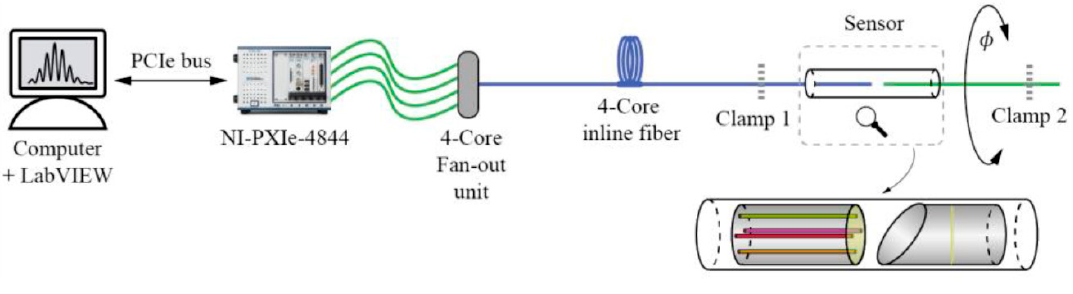
Figure 2. Experimental setup.